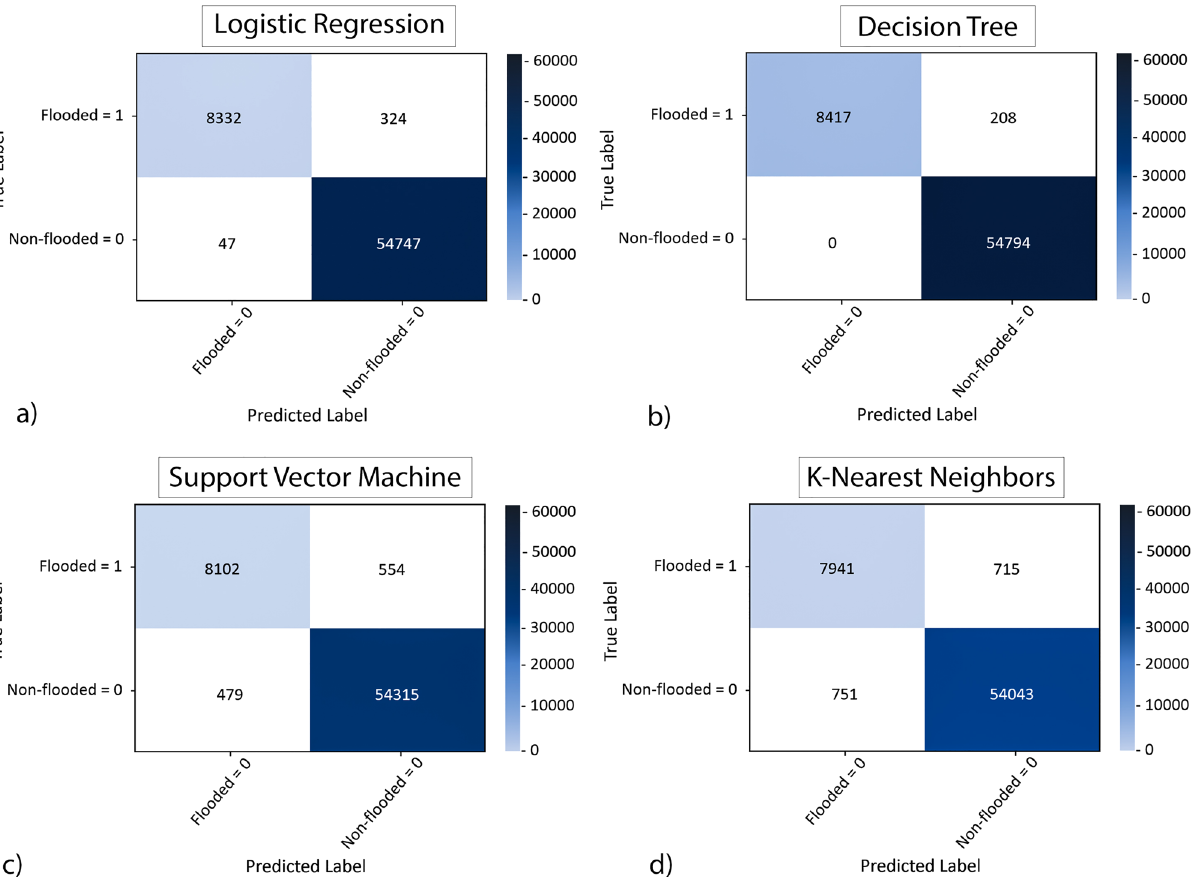
Figure 8. Confusion Matrix is used to observe the performance of ML classifiers i.e., logistic regression ( a ), decision tree ( b ), support vector machine ( c ) and K-nearest neighbors ( d ). Total number of predicted cells from ML classifiers are compared to the actual values from hydraulic model to extract the number of correctly predicted cells.